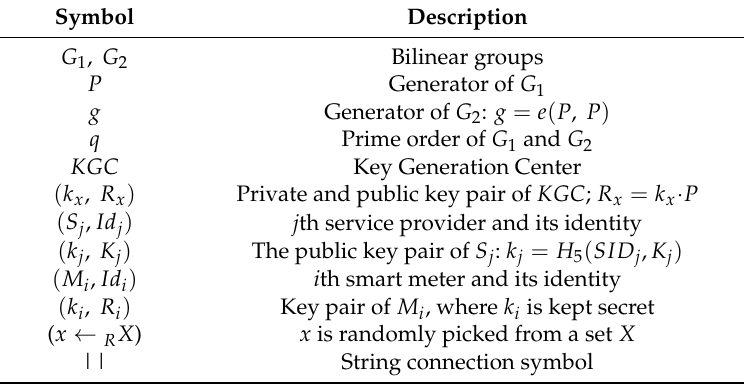
Table 1. Symbols used in Odelu’s scheme.